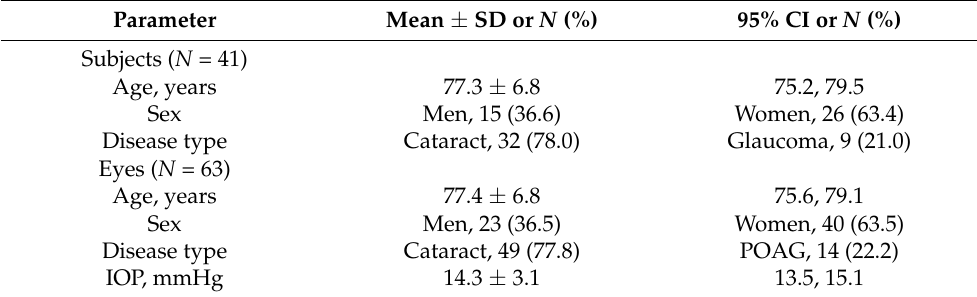
Table 1. Demographic subject data.